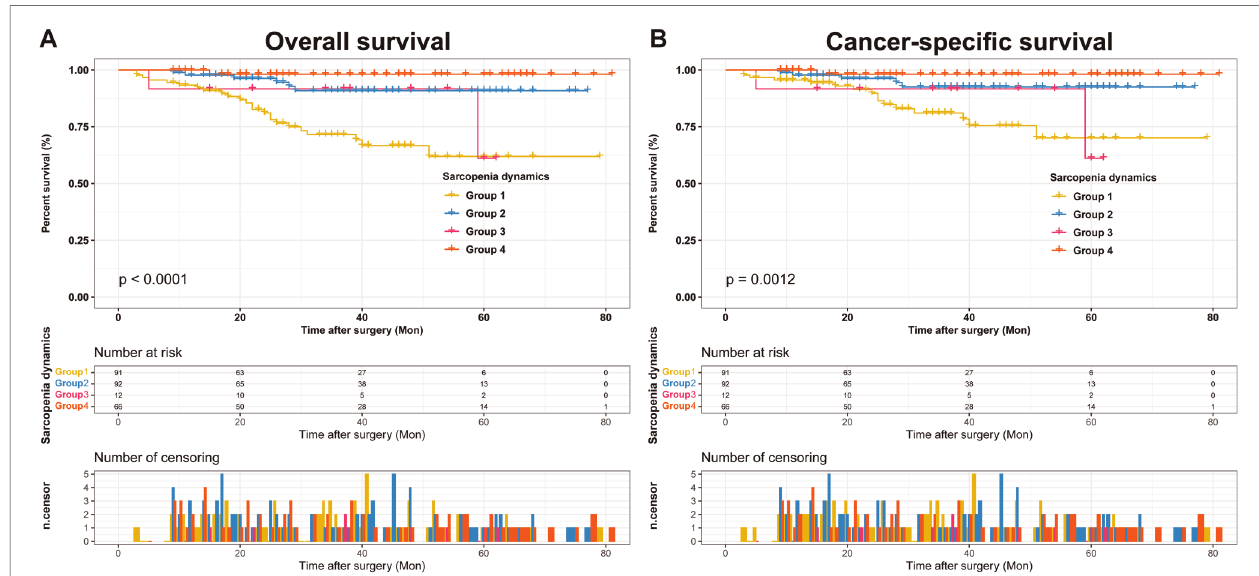
FIGURE 3 | Kaplan-Meier curves for OS and CSS strati fi ed by sarcopenia dynamics. ( A ) Sarcopenia dynamics OS; ( B ) Sarcopenia dynamics CSS. Abbreviations: OS, overall survival; CSS, cancer-speci fi c